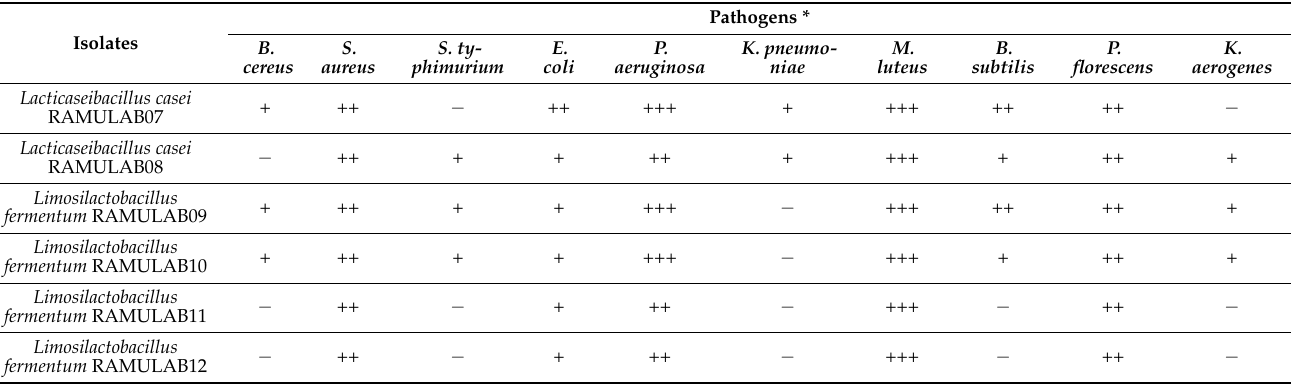
Table 5. Antimicrobial activity of isolates.